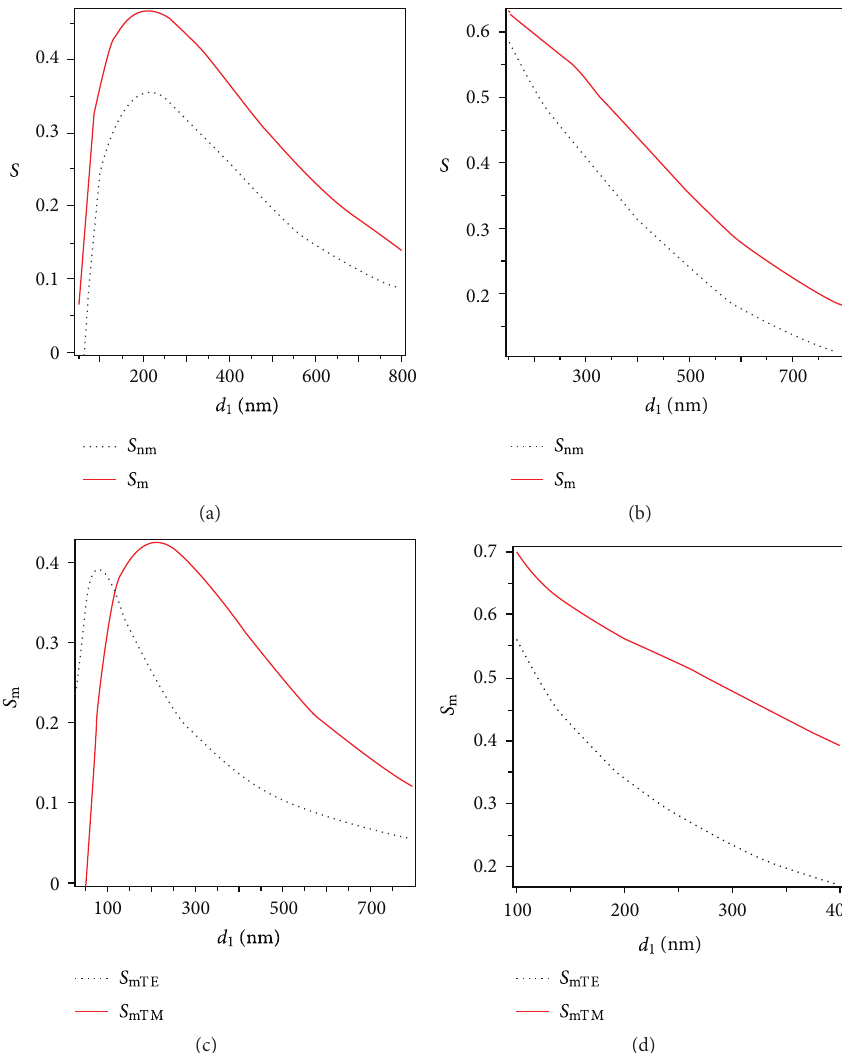
Figure 4: Sensitivity versus the guiding layer thickness 𝑑 1 for the proposed sensor ( 𝑎 𝑚 = 𝜀 𝑚 /𝜀 𝑔 = −0.5 , 𝑛 = −0.6 , and 𝑑 2 = 30 nm) with a metamaterial layer (red solid line) and without a metamaterial layer (blue dotted line): (a) normal symmetry ( 𝑎 𝑠 = 0.55 and 𝑎 𝑐 = 0.5 ) and (b) reverse symmetry ( 𝑎 𝑠 = 0.5 and 𝑎 𝑐 = 0.55 ). Sensitivity versus the guiding layer thickness 𝑑 1 for TM mode ( 𝑆 ) (blue dotted line) ( 𝑑 2 = 20 nm, 𝑎 𝑚 = 𝜀 𝑚 /𝜀 𝑔 = −0.5 , and 𝑛 = −0.6 ): (c) normal symmetry ( 𝑎 𝑠 = 0.55 and 𝑎 𝑐 = 0.5 ) and (d) reverse mode ( 𝑆 mTE symmetry ( 𝑎 𝑠 = 0.5 and 𝑎 𝑐 = 0.55 )